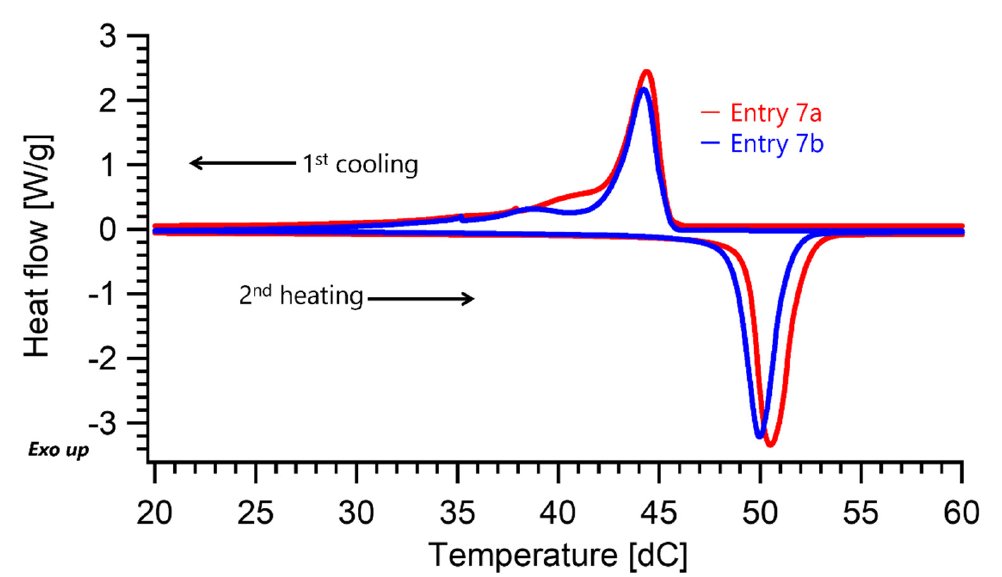
Figure 7. DSC curves before (red line, Entry 7a) and after TC removal from PSA17k (blue line, Entry 7b). The heating/cooling rate was 5 °C/min.